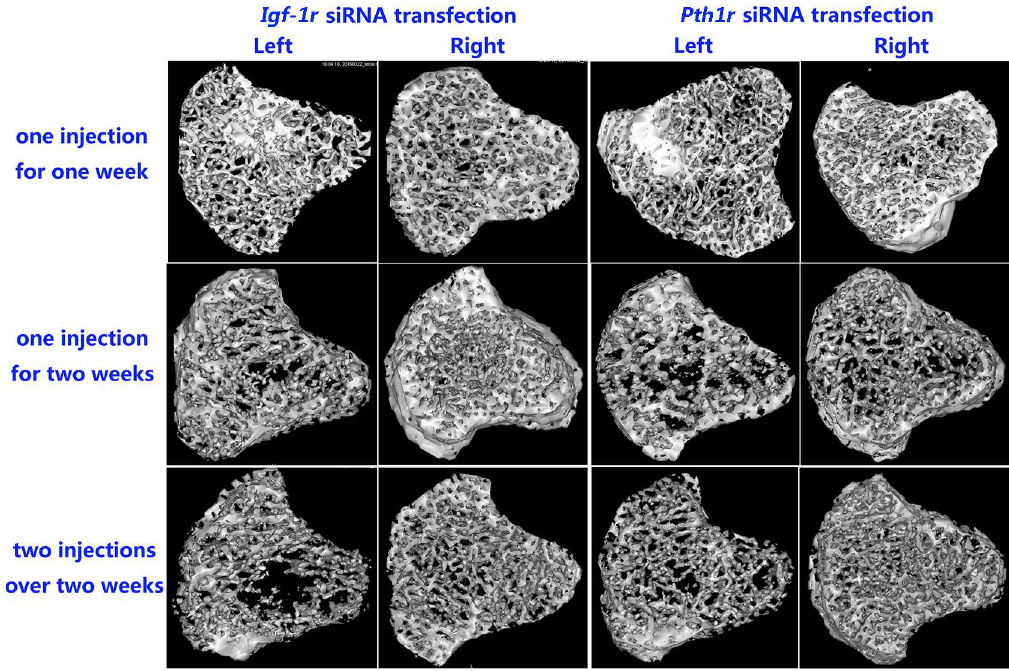
Fig 5. Representative Three-dimensional Trabecular Architecture of the Tibia After Pth1r or Igf-1r siRNA Injection. In the Igf-1r siRNA transfectiongroups, the trabeculaein the left tibias treated with Igf-1r siRNA and IGF-1 were dramatically weakened compared to those in the right tibias treated with IGF-1 only. In the Pth1r siRNA transfectiongroups, the trabeculaein the left tibias treated with Pth1r siRNA and rhPTH (1–34) were also significantly weakenedcomparedto those in the right tibias treated with rhPTH (1–34) only.